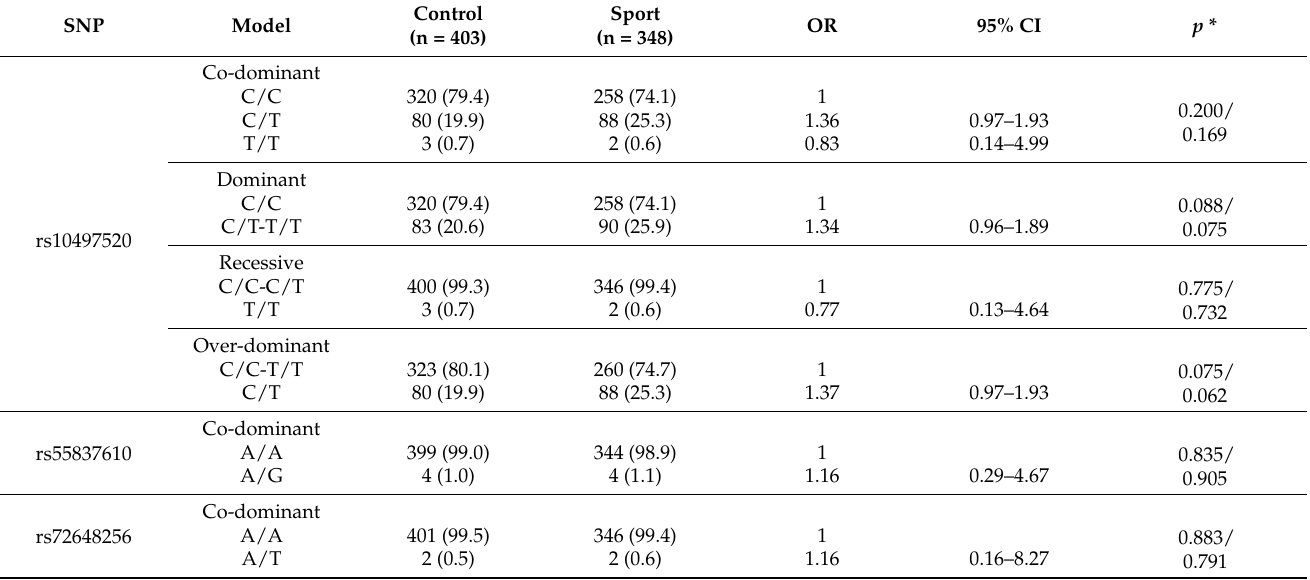
Table 1. Single SNP association analysis for cases (all sports) and controls.